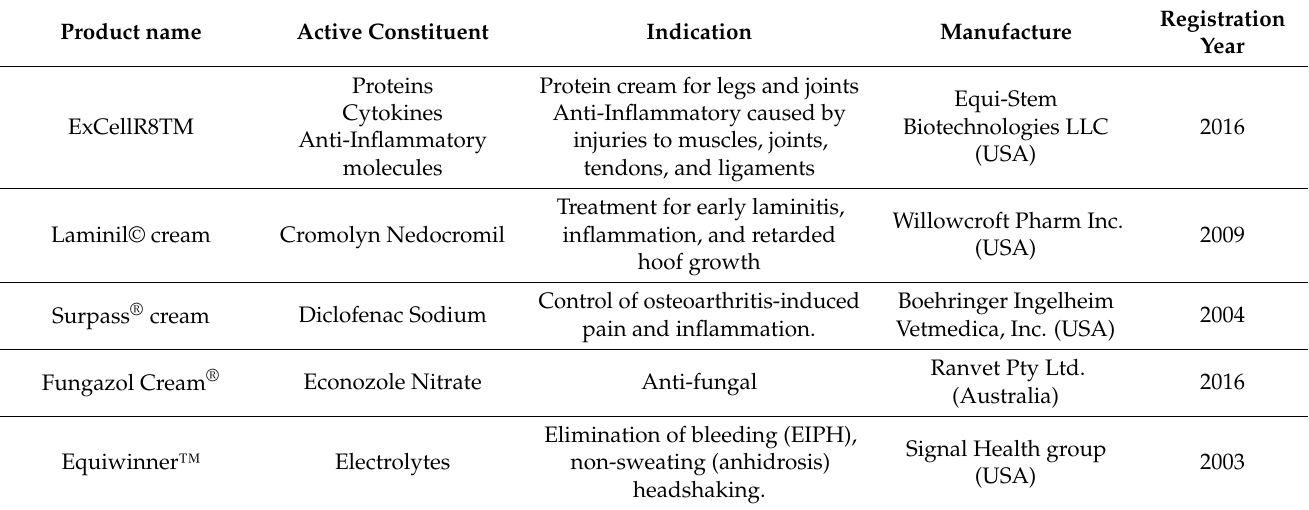
Table 4. Examples of Marketed/Registered equine topical/transdermal products and their